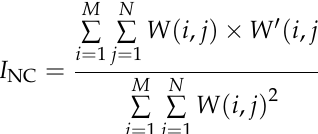
Table 1. Several typical attacks and their corresponding abbreviations.